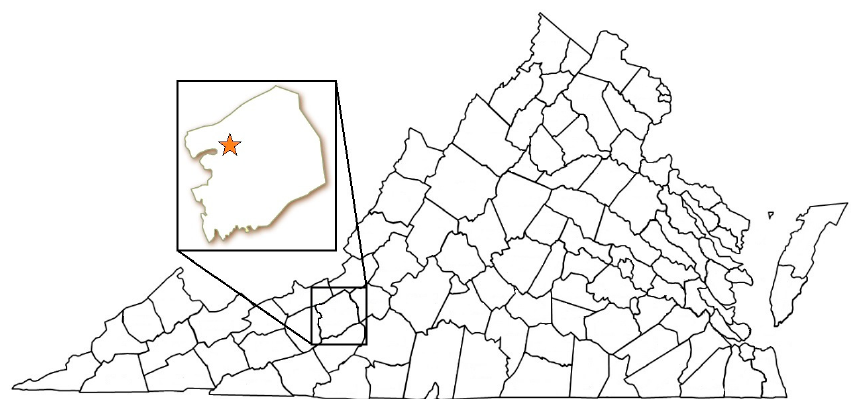
Figure 1. Timber harvest was located in Montgomery County of southwestern Virginia, located on the southeastern coast of the United States. Map is not to scale.